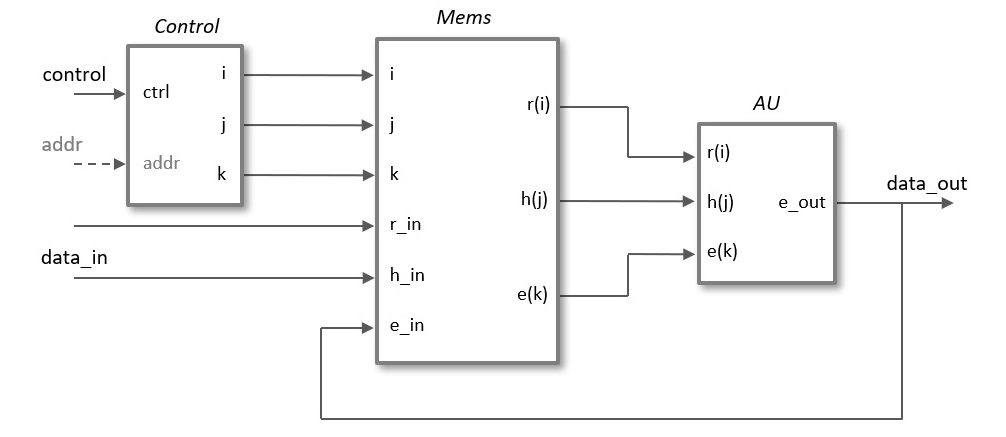
Figure 5. Block diagram for the serial implementation of the polynomial multiplier required in